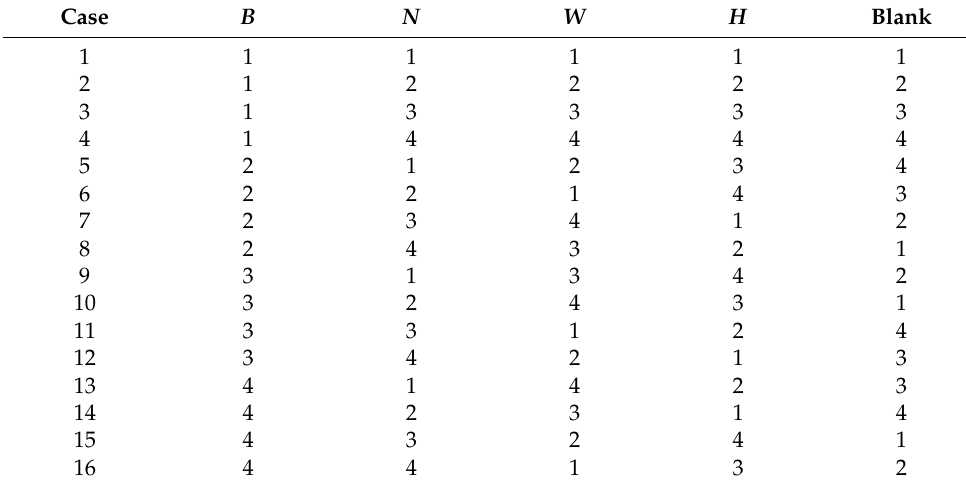
Table 3. The L 16 (4 5 ) orthogonal